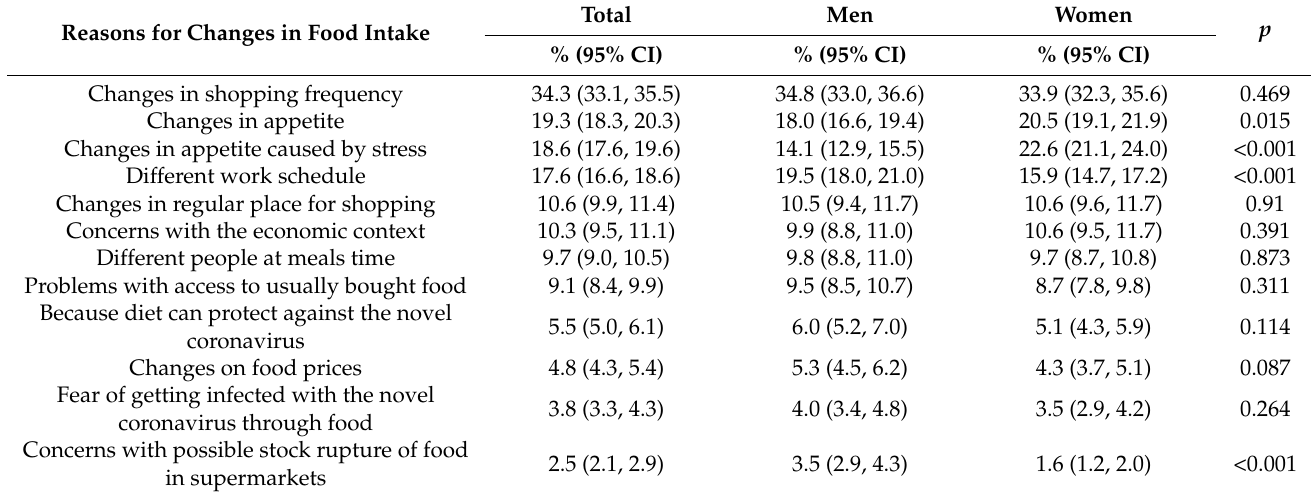
Table 6. Reasons for changes in food intake during COVID-19 social